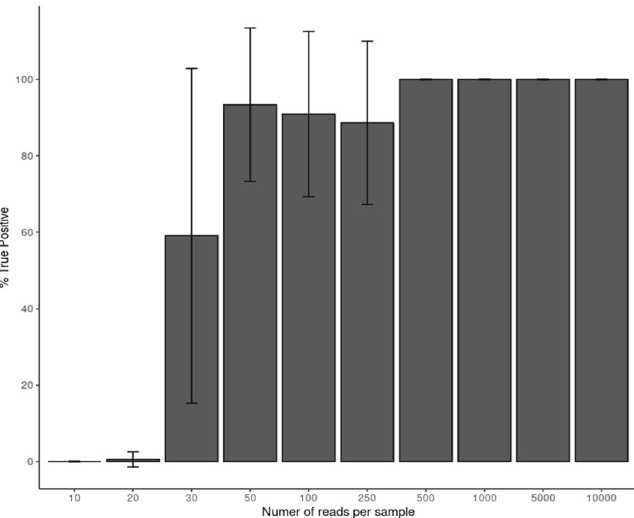
Figure 1. Downsampling the sequencing data of the 12 samples to 10–10,000 reads per sample. For each downsampled library the rate of variants detected from the full dataset variant list was